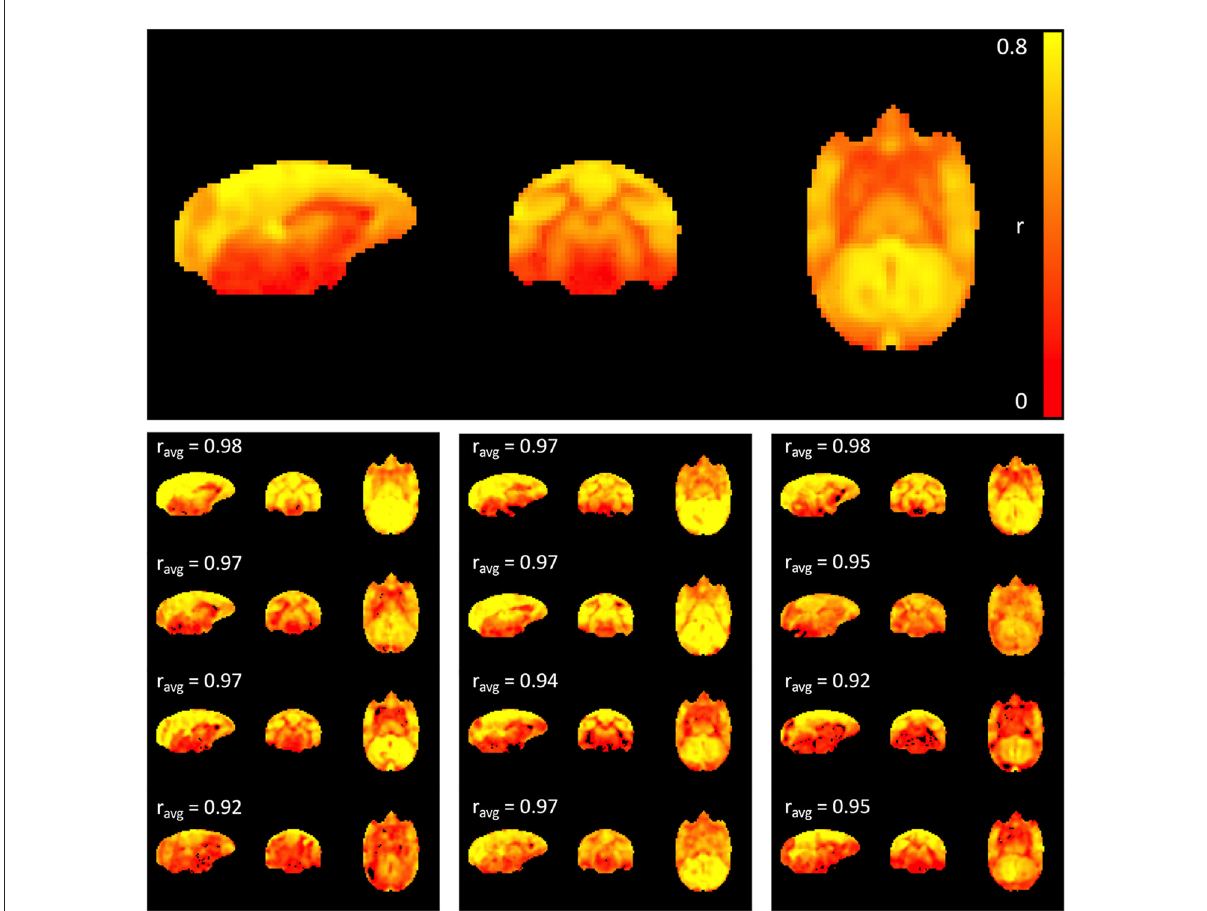
FIGURE1 Maximum correlation coefficient map. The top panel shows the average map across all 12 subjects, while the maps at the bottom represent subject-specific maximum correlation coefficient maps. The percentage of variance explained by the time shifted LFO regressor in each voxel is 100 * (correlation coefficient) 2 . Cross-correlation between each individual map and the average map was performed, and the correlation coefficient is indicated above each individual map; note that correlation values are strong across all subjects ( >